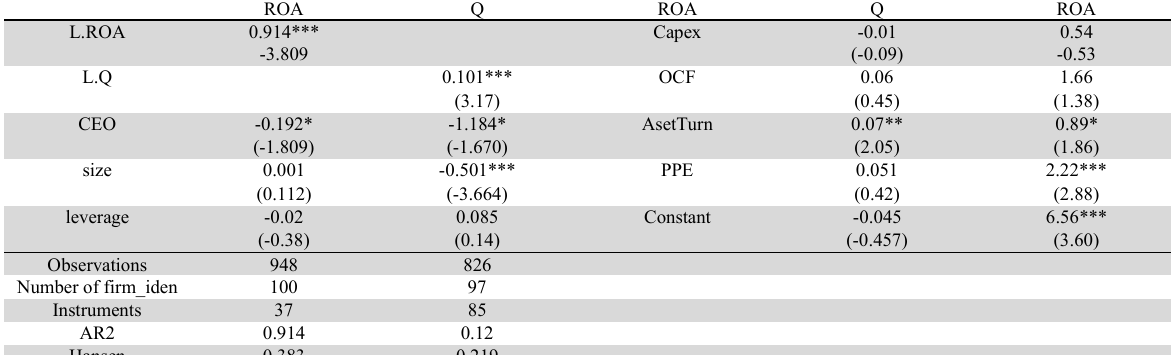
System GMM results comparing performance between firms manged by foreign CEO and local